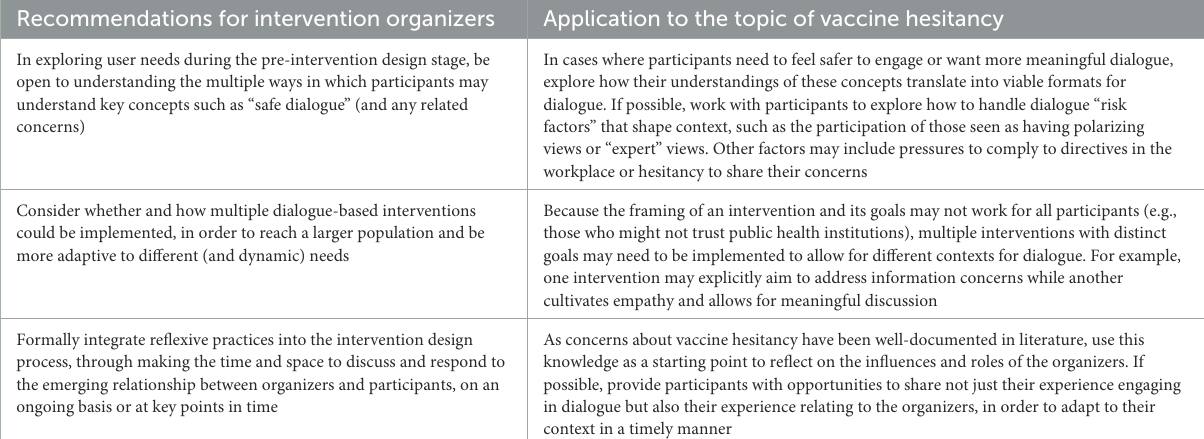
TABLE 1 Recommendations for more context-sensitive dialogue-based intervention